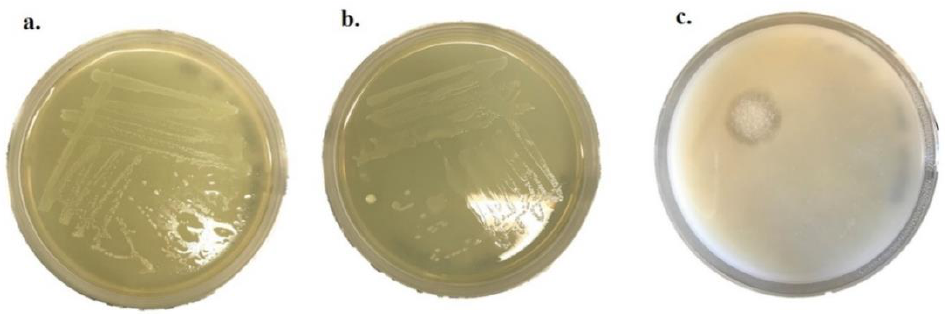
Figure 4. Hemolytic activity of P. pentosaceus BalaMMB-P3.